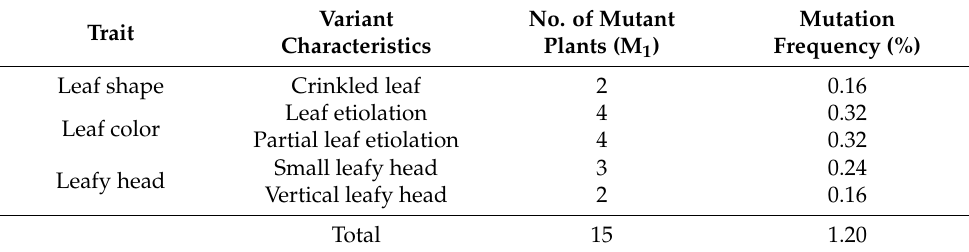
Table 2. Characterization of mutation types in M 1 plants of Chinese cabbage (microspore EMS mutagenesis).